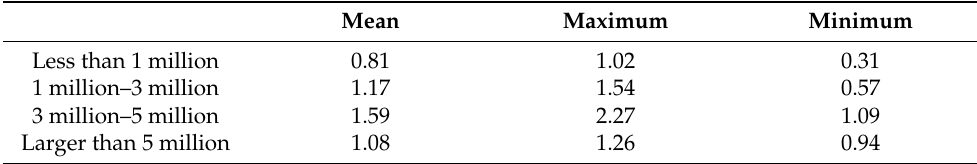
Table 3. The multipliers of different city size levels.